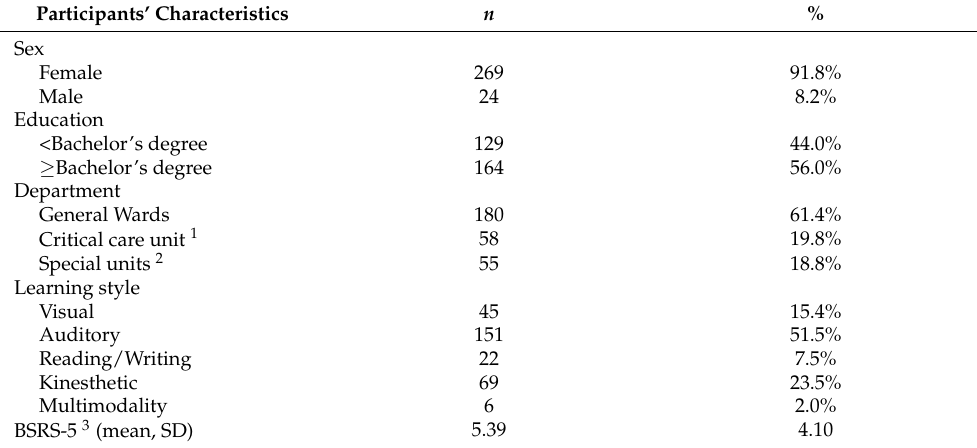
Table 1. Demographics and clinical characteristics ( N =